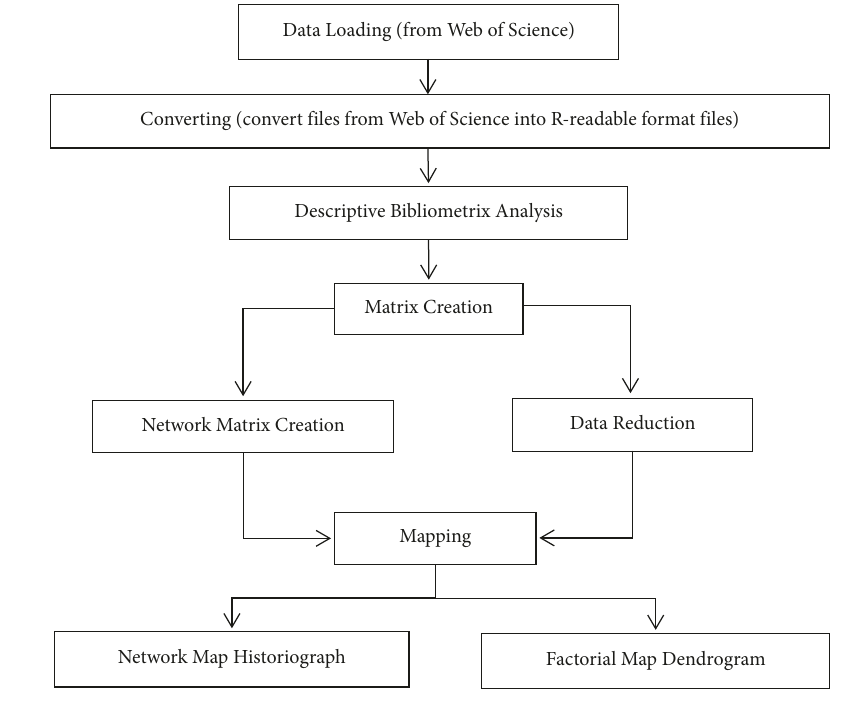
Figure 1: Bibliometric analysis